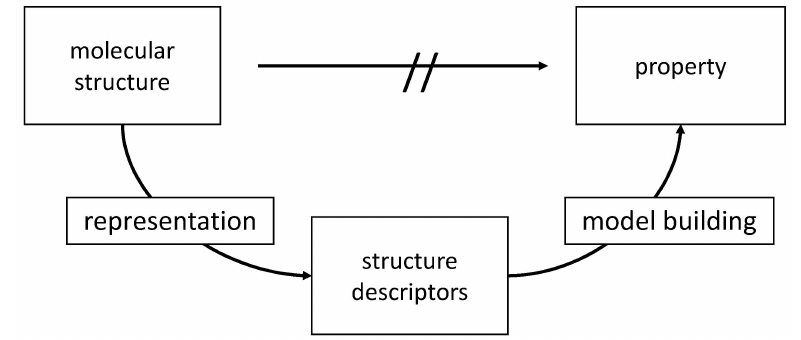
Figure 1. The basic approach to QSAR/QSPR: In the first step, a molecular structure is represented by structure descriptors. In the second step, a dataset of structures as represented by their descriptors and their associated properties is submitted to a data analysis and model building